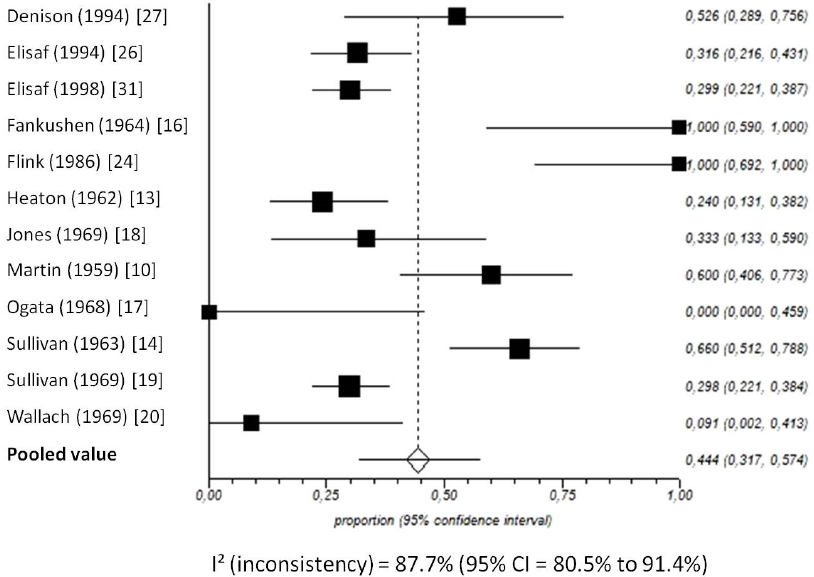
Figure 5. Forest plot of individual studies and pooled proportion of hypomagnesemia in patients with alcoholism, including 95% confidence intervals (95%-CI). The size of the squares is related to